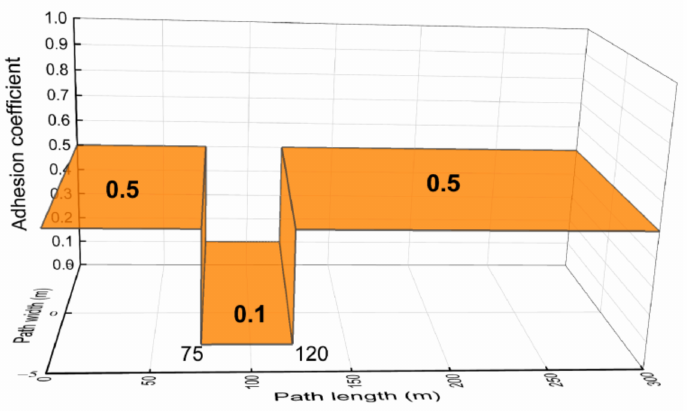
Figure 8. Adhesion coefficient of the joint road.